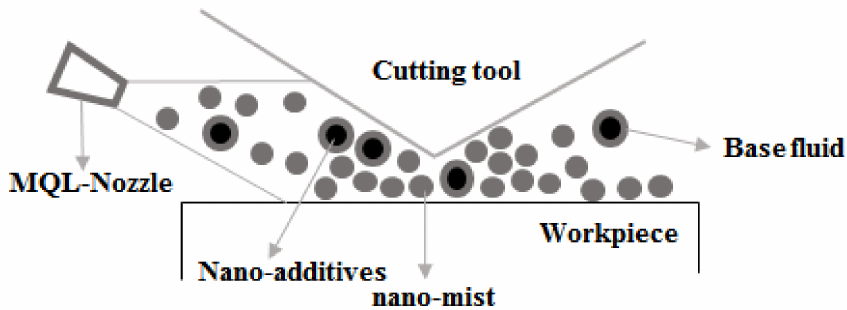
Figure 4. The MQL-nano cutting fluid mechanism (rolling effect)